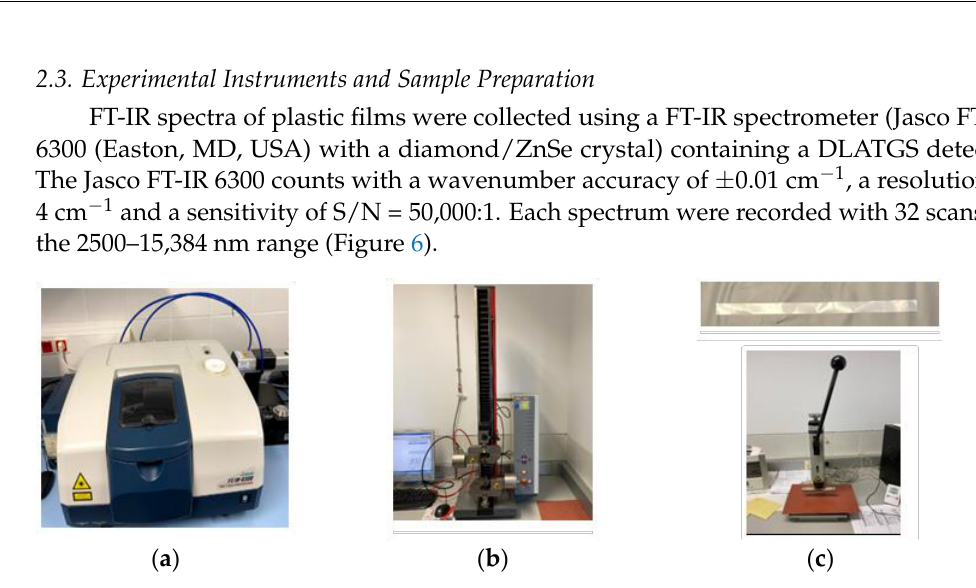
Figure 6. ( a ) Jasco FT-IR 6300; ( b ) ZwickRoell BZ1-MMZ2.5.ZW01; ( c ) 1 × 15 cm specimen and press.